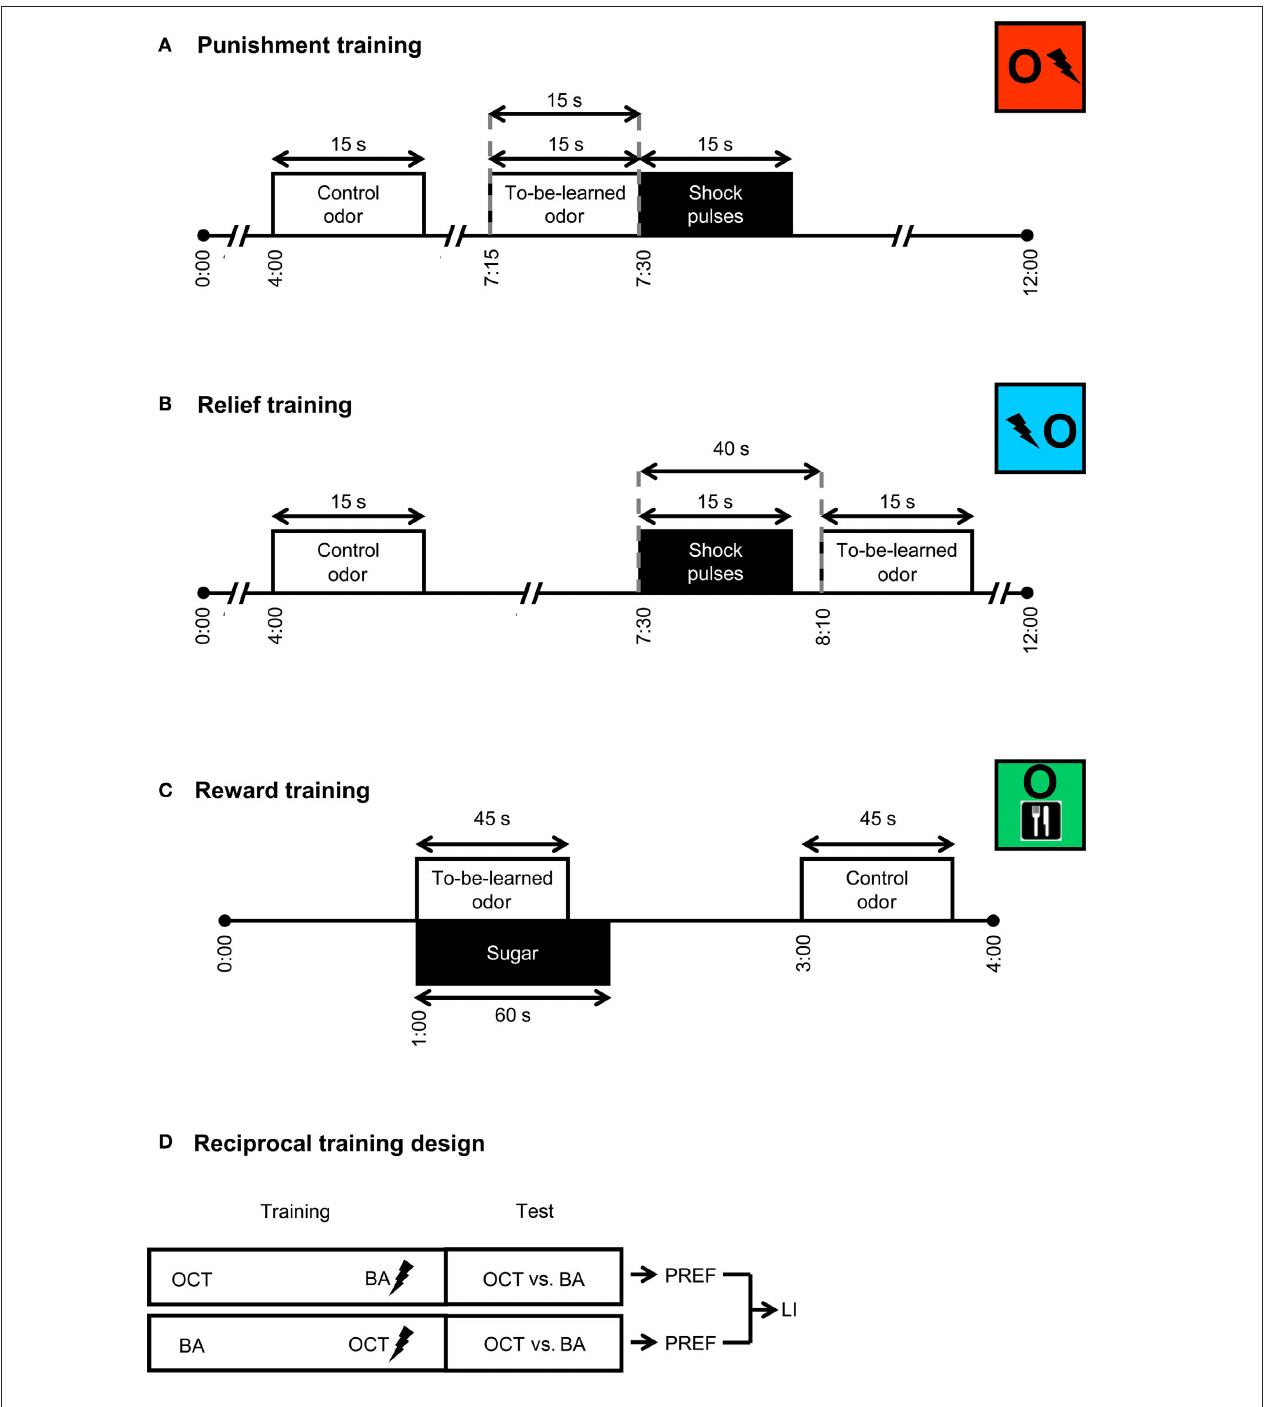
to-be-learned odor and sugar. For each kind of training, we used a reciprocal design (D) : two groups were trained in parallel; for one of these, e.g., 3-octanol (OCT) was the control odor and benzaldehyde (BA) was to be learned; the other group was trained reciprocally. Each group was then given the choice between the two odors. Based on the flies’ distribution, preference indices (PREF) were calculated. Based on the two reciprocal PREF values, we calculated a learning index (LI). The situation is sketched for punishment learning, but also applies to relief and reward